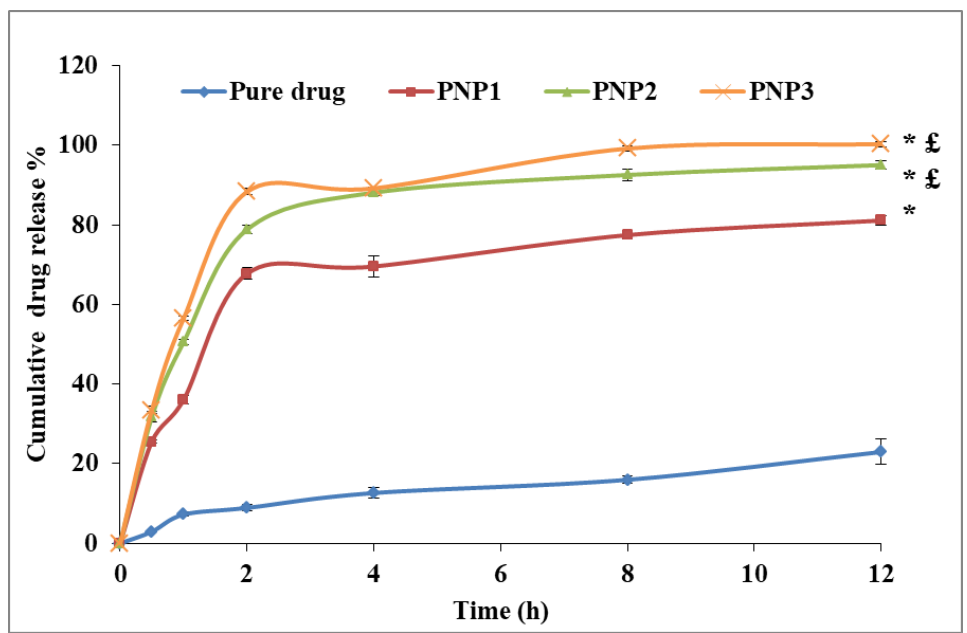
Figure 2. The cumulative in vitro release of DOXY from the different formulas. Data for the cumulative release were measured over 12 h and presented as mean ± SD. Statistical analysis for the last data point was done using one-way ANOVA followed by Bonferroni’s post-hoc test at probability value < 0.05, * Compared to the free drug, £ Compared to PNP1.